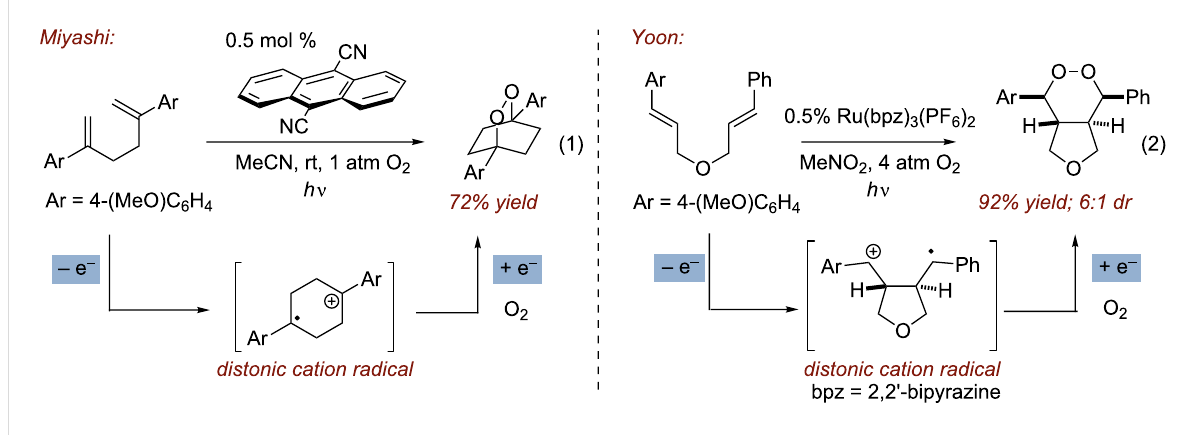
Scheme 1: Endoperoxide formation via cation radicals. In both examples, single electron oxidation is followed quickly by cyclization to form stabilized distonic cation radical intermediates. The distonic intermediates are trapped by O 2 and furnish the shown bicyclic products after reduction.